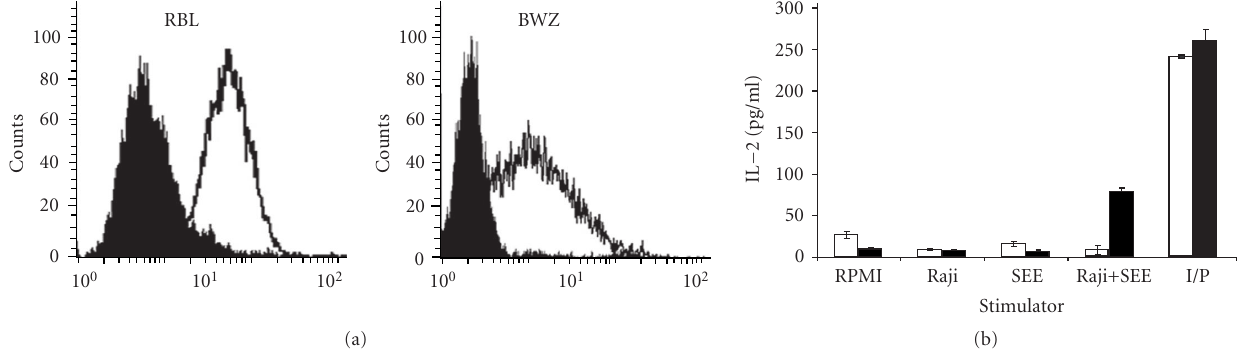
Figure 4: Expression of functional scTR on the surface of T and non-T immune cells . (a) Rat basophilic leukemia (RBL) or BWZ cells were transfected with the scTR-pEF6 and were stained for surface expression with anti-TR BF1 antibody (open) or with isotype control (filled) histogram. (b) IL-2 secretion from BWZ cells (open bars) or BWZ-scTR (filled bars) following stimulated with SEE superantigen or with anti-TR BF1 antibody. Stimulation with Ionomycin/PMA (I/P) served as the positive control.